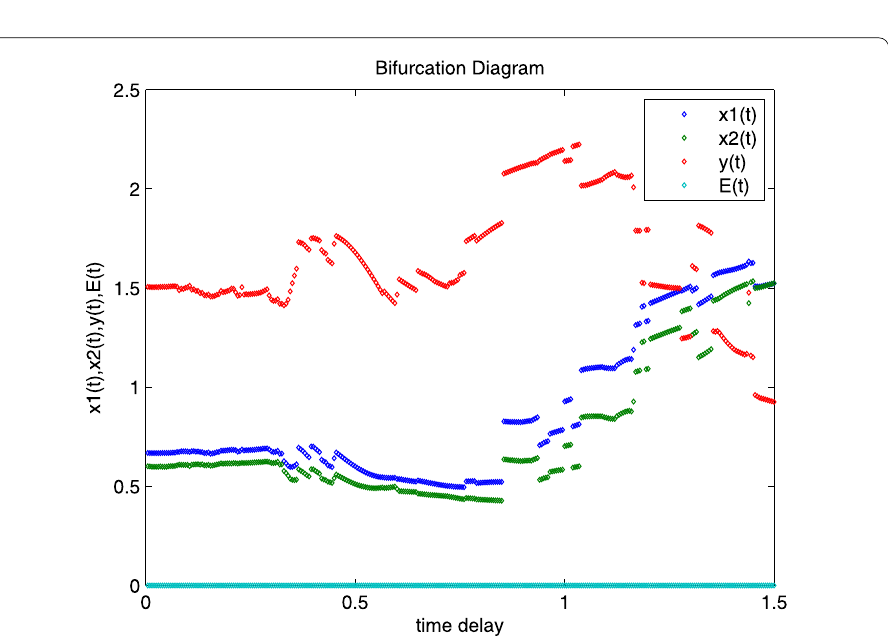
Figure 3 The bifurcation diagram of system (4) with τ = 0.7234 at P 3 . The bifurcation diagram of system (4) with τ = 0.7234 at P 3